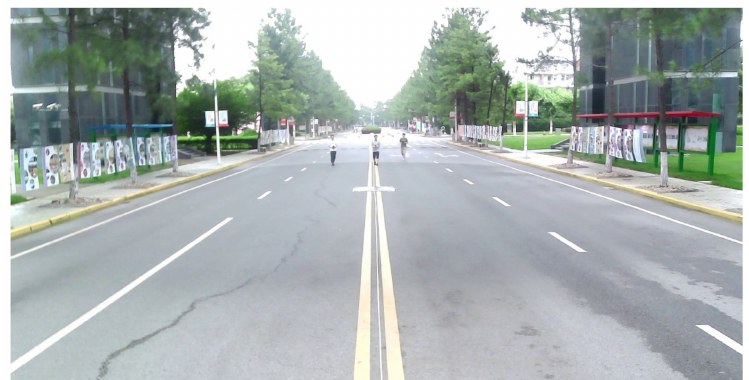
Figure 6. Pedestrian tracking experiment on a wide road.